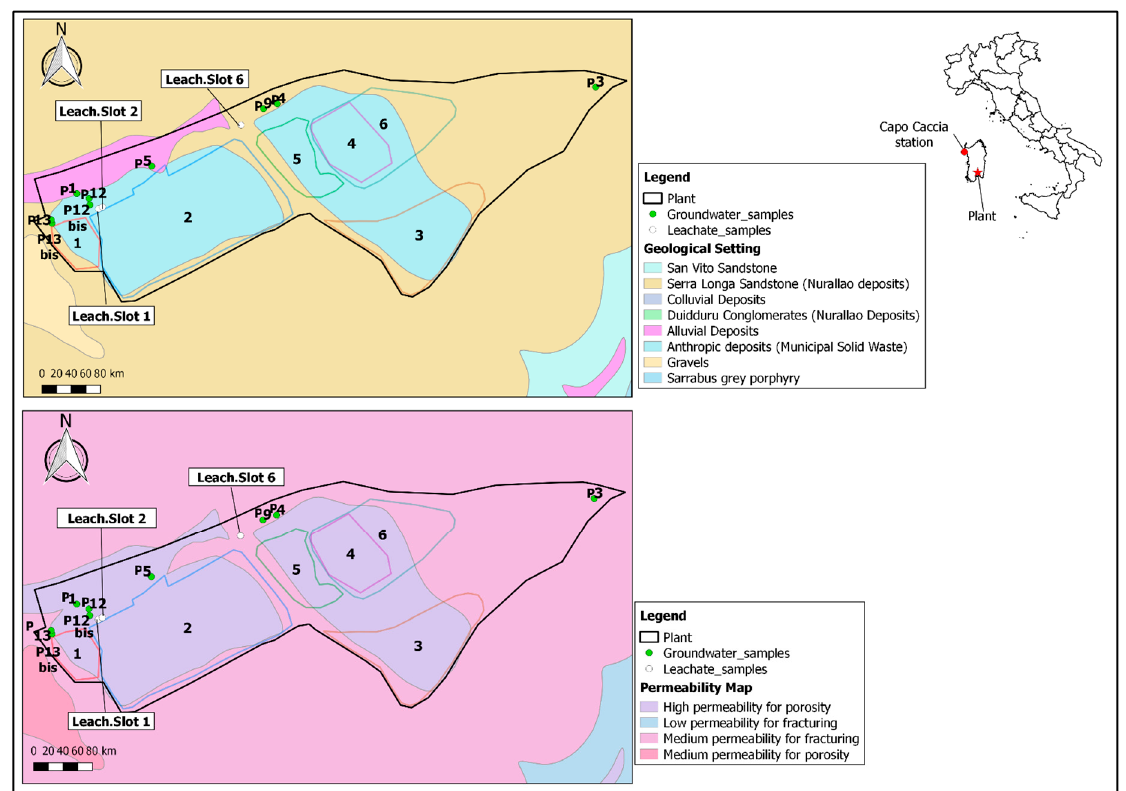
Figure 1. Geological ( above ) and Permeability ( below ) Map of Case History I.